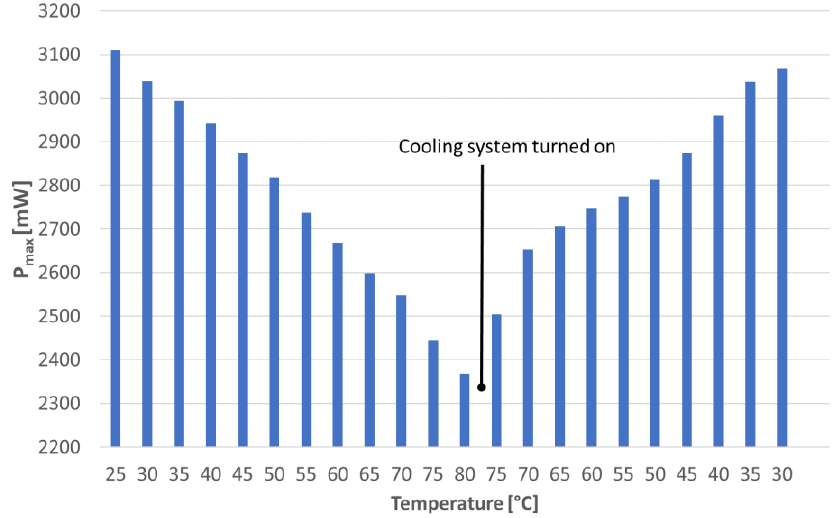
Figure 8. PV minimodule’s maximum power dependence on its surface temperature during the experiment using the dedicated Artificial Sun setup.